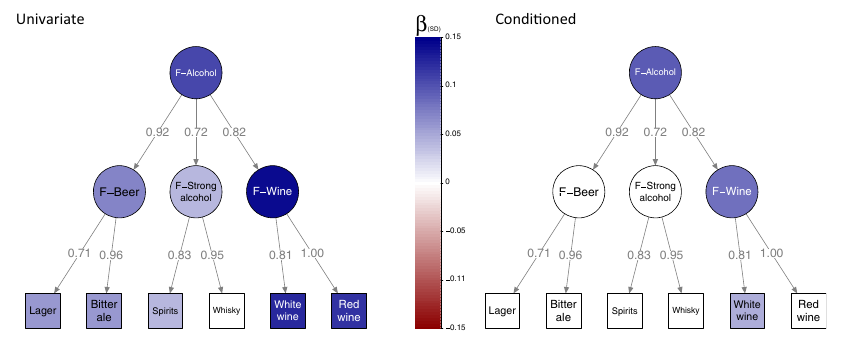
Fig. 5 Example of univariable vs conditioned analysis of rs1229984 in ADH1B. The path graph represents the hierarchical model up to the alcohol trait. Numbers over the edges report the standardized loadings. Colour is proportional to effect size. Effect sizes with p < 1.4 × 10 − 3 (0.05/34 independent traits) have been shrunk to 0.